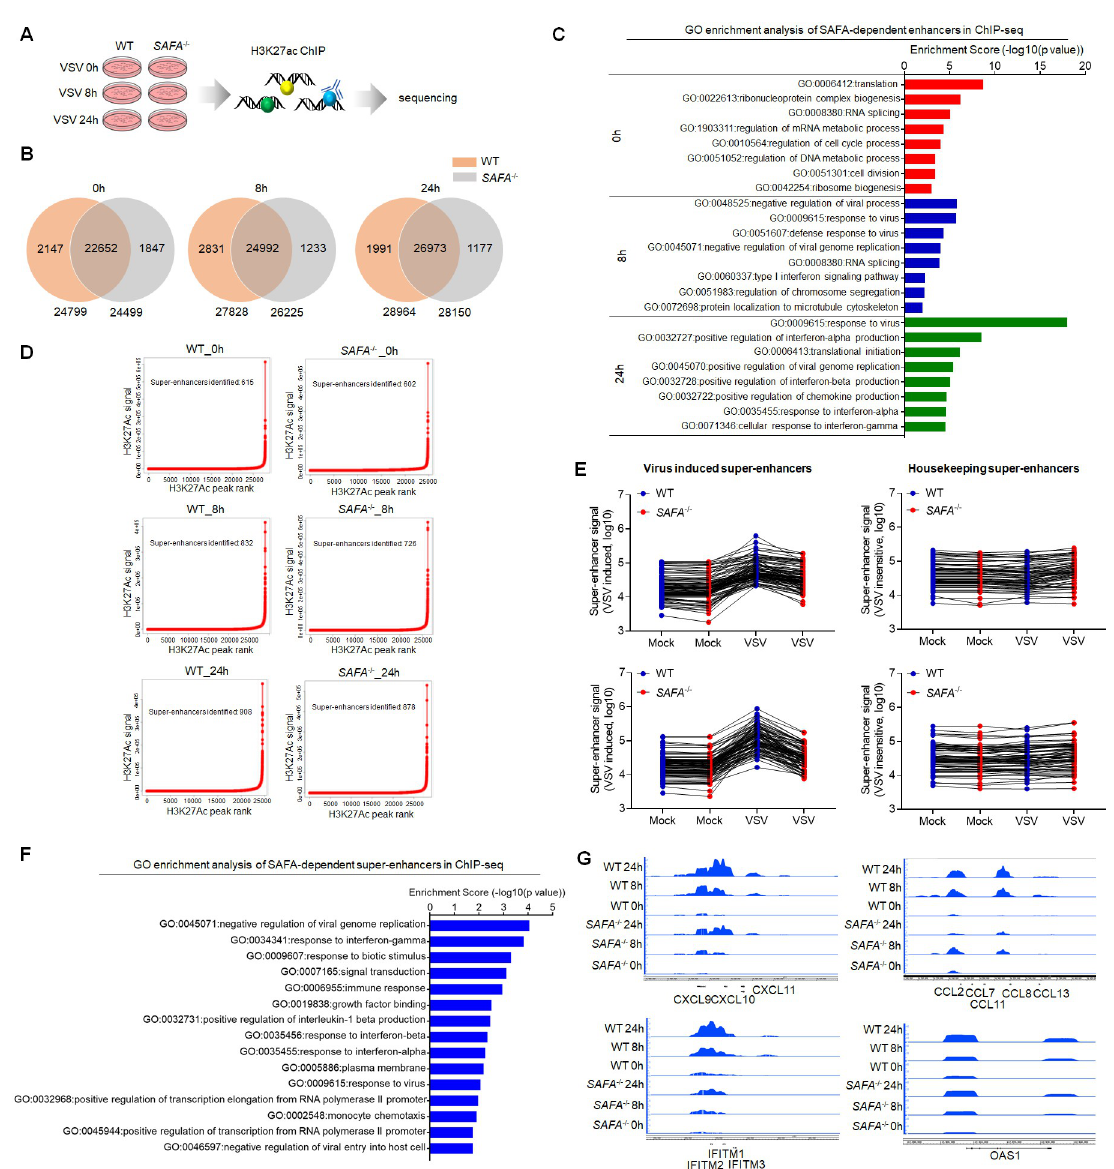
Fig 2. SAFA deficiency decreased the activation of antiviral immune genes. (A) Models depicting the ChIP-seq assay of H3K27ac in Wild-type (WT) and SAFA − / − THP-1 cells with VSV infection for indicated hours. (B) Venn diagram showing amounts of enhancers in WT and SAFA − / − THP-1 cells with VSV infection. (C) GO term enrichment analysis of enhancers-related genes affected by SAFA depletion in ChIP -seq. (D) Delineation of -enhancers super based on H3K27Ac occupancy in WT and SAFA − / − THP-1 cells with VSV infection using the ROSE algorithm. (E) Line graph (RPKM) showing SAFA in regulation of VSV-induced and housekeeping supper- enhancer formation. (F) GO term enrichment analysis of super-enhancers related genes affected by SAFA depletion in ChIP -seq. (G) Genome browser views of ChIP -seq signal for the indicated genes. The cells were infected by VSV at 0.1 MOI. Data were pooled from two independent experiments (B-F). Data were representative of two independent experiments (G).